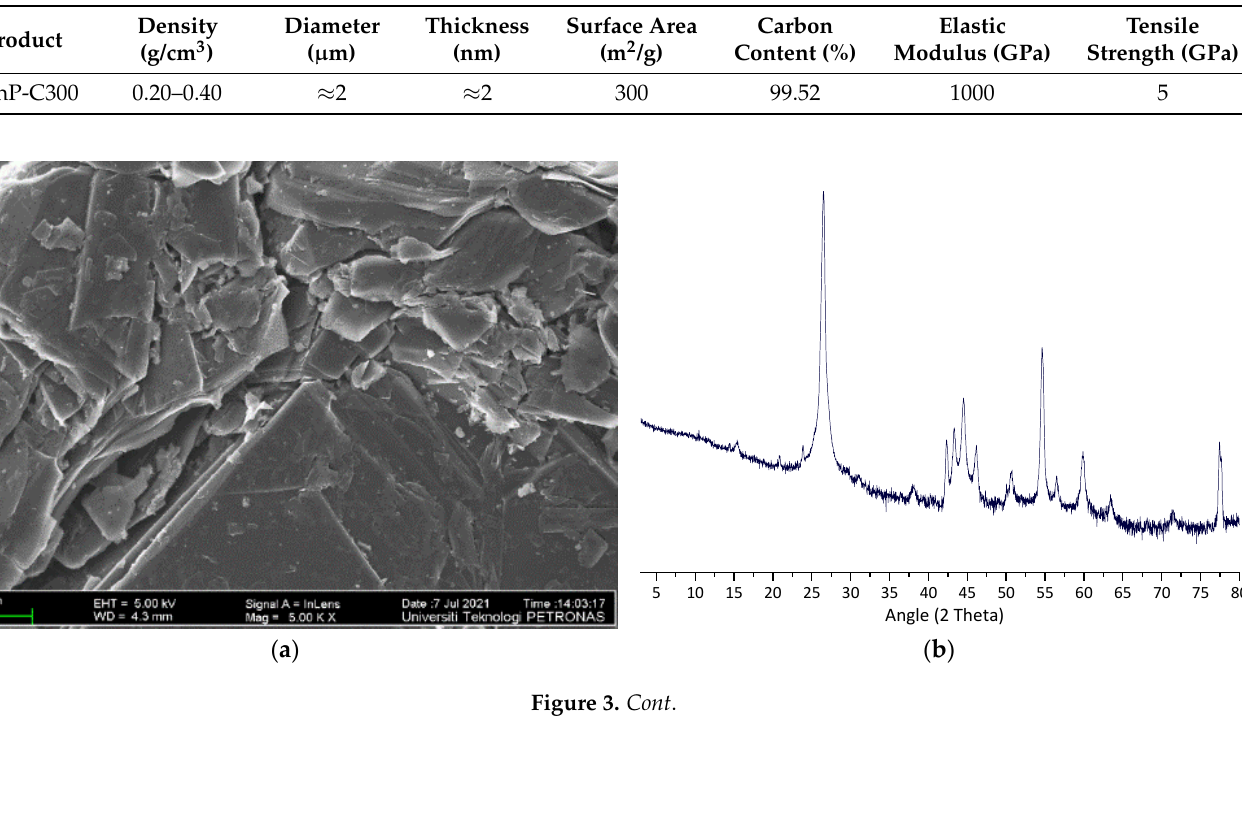
Table 4. Properties of GnP.